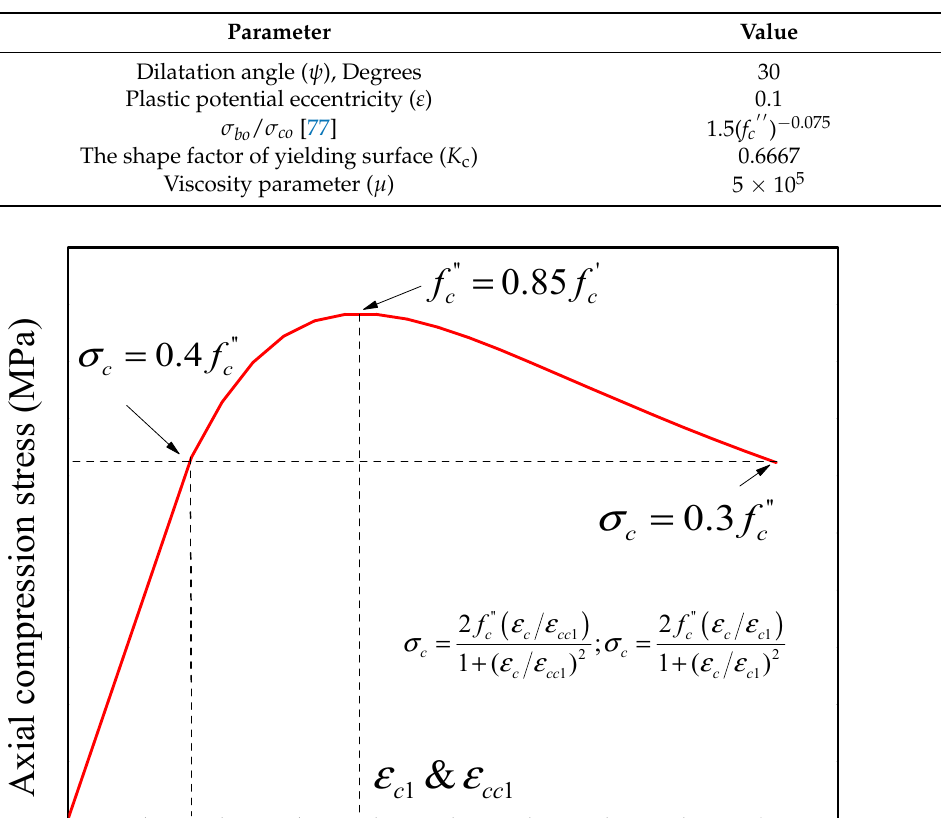
Table 4. Plasticity parameters of concrete for CDP.